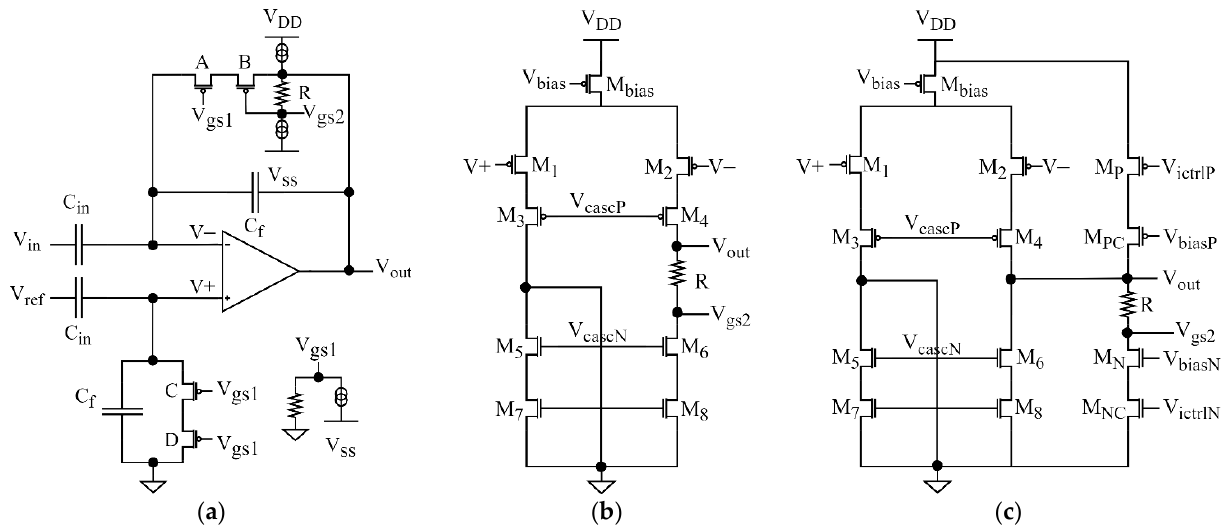
Figure 11. Design of the preamplifier: ( a ) Fixed- V gs AC-coupling architecture using polysilicon resistors; ( b ) Design of the preamplifier with integrated polysilicon resistor; ( c ) Design of preamplifier for the test chip.